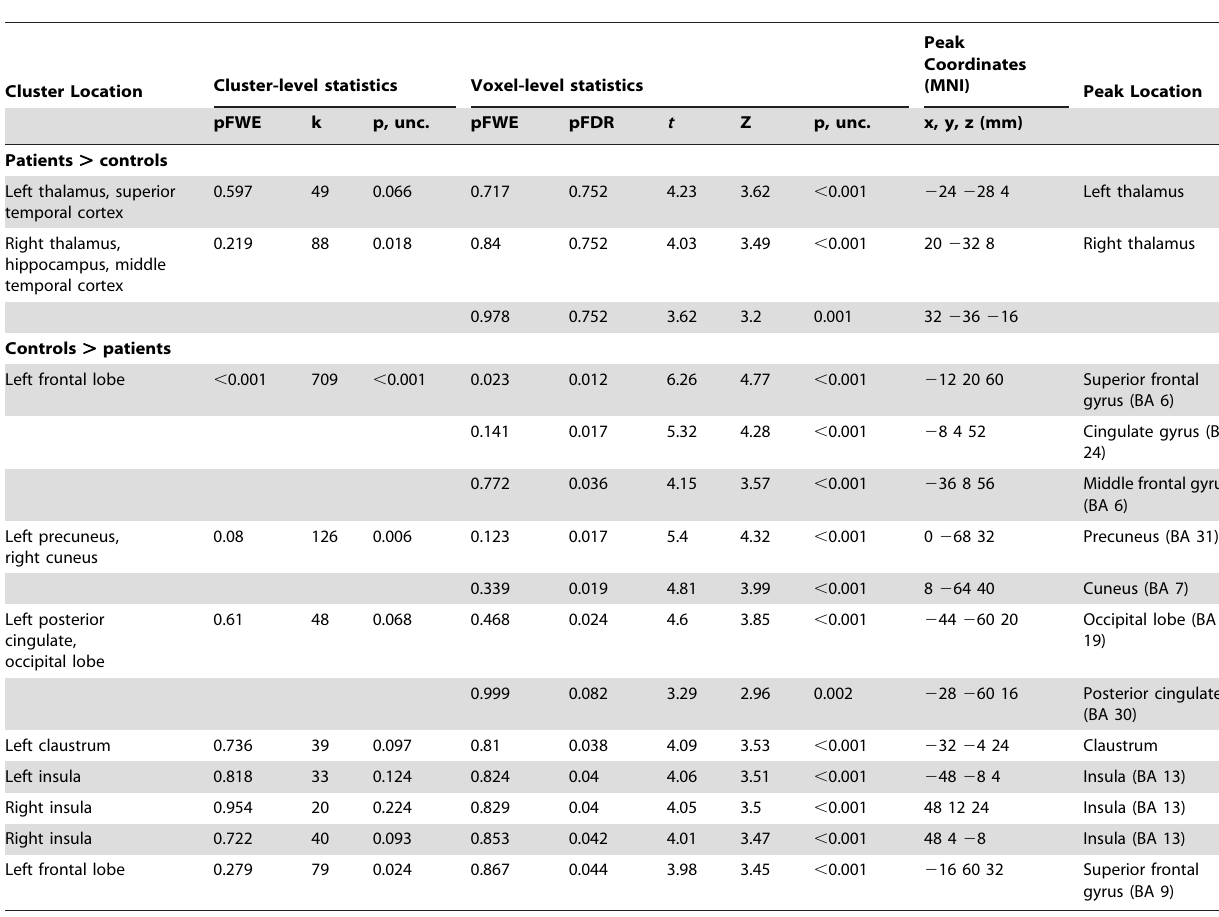
Table 3. Group differences in amygdalar correlations.